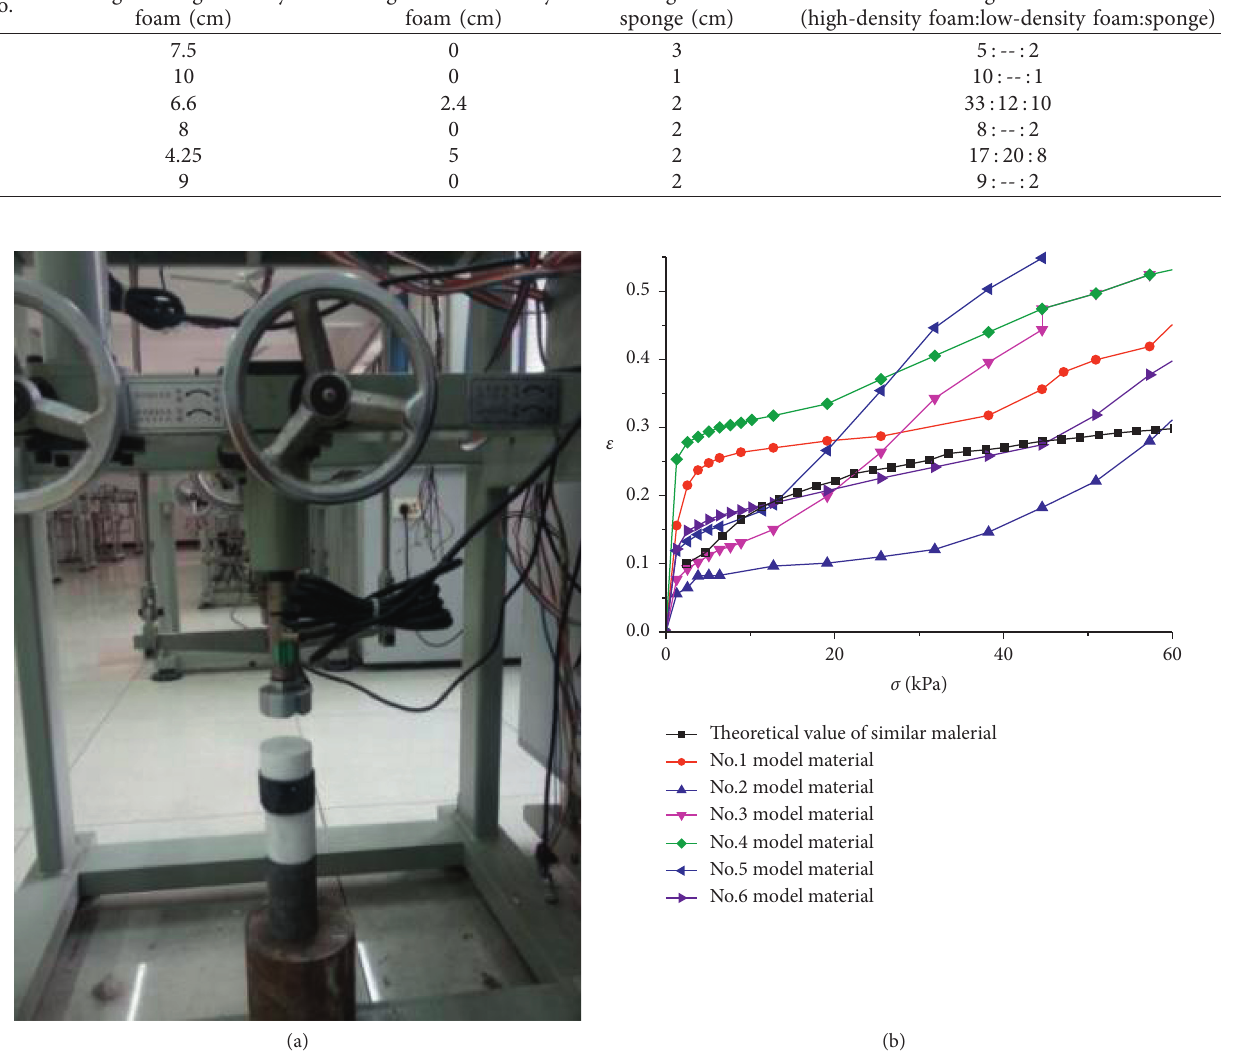
Figure 4: Compaction test photos and curves of similar materials of filling body. (a) Compaction test photos. (b) Compaction test